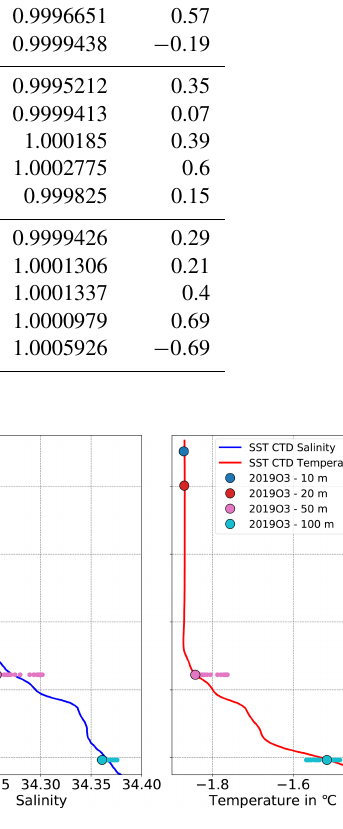
Figure 6. Comparison between SST-CTD and 2019O3 data on 26 April 2020. Red and blue lines represent salinity and tempera- ture recorded by the SST-CTD, respectively. Circles represent buoy data closest in time to the SST-CTD cast. The colored dots show the values of the corresponding buoy CTD within 30min before and af- ter the SST-CTD cast. Buoy data at 10 and 20m are hidden below the